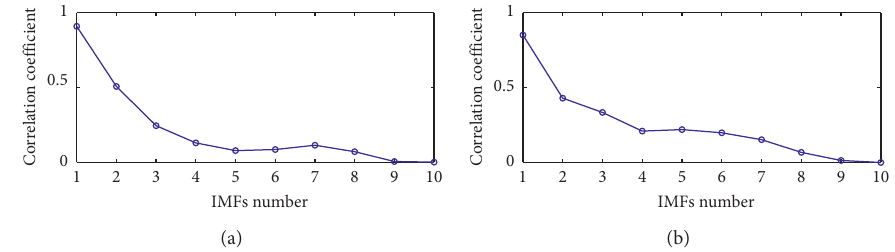
Figure 23: Correlation coefficients between each IMF and the original vibration signal. (a) Bearing 11. (b) Bearing 12.